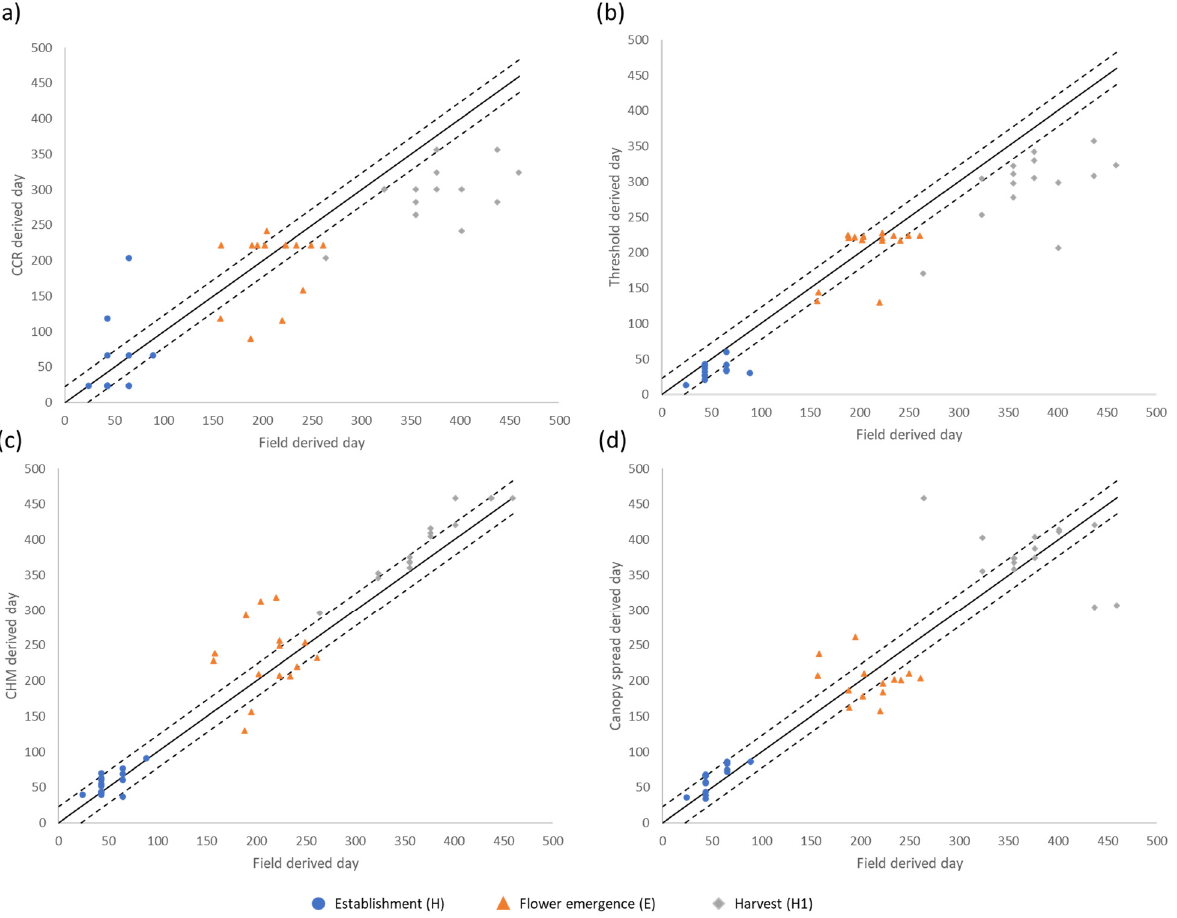
Figure 9. Scatterplot of derived phenology of banana plants compared to field-based observations for ( a ) the curvature change rate (CCR)-based method ( b ), the threshold-based method, and extraction based on the minimum and maximum values for ( c ) the canopy height model (CHM) and ( d ) canopy spread. The solid line is the 1:1 line and dash lines represent the average number of days between UAV flights (+/ − 23 days).